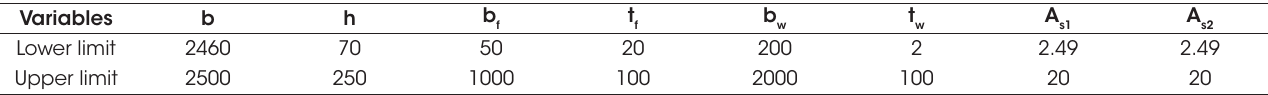
Limit parameter for design variables (dimensions in mm and area in cm 2 )